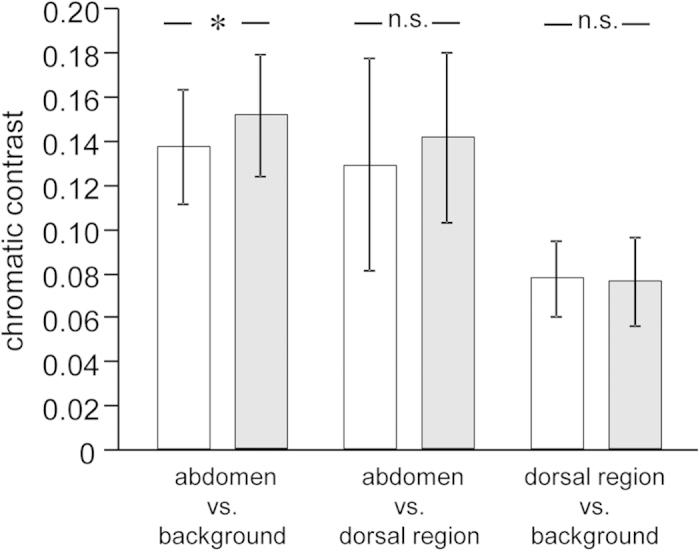
Chromatic contrasts between body regions and background as short-term response.Shown are chromatic contrasts (abdomen vs. background, abdomen vs. dorsal region and dorsal region vs. background) of females before (white bars) and after (light gray bars) presentation of a computer animation of a reproductively active male. Plotted are means and standard deviations. n.s. p > 0.10; *p < 0.05.